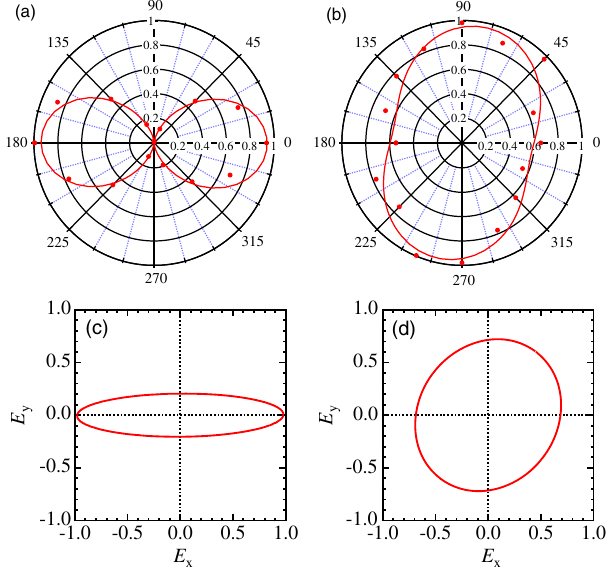
FIG. 10. Example of the processed signal of the e-TOF showing single shot data for the electron-beam distribution on He for the FEL at 32-nm horizontally polarized (a) and circularly right polarized (b). Panels (c) and (d) report the corresponding reconstructed